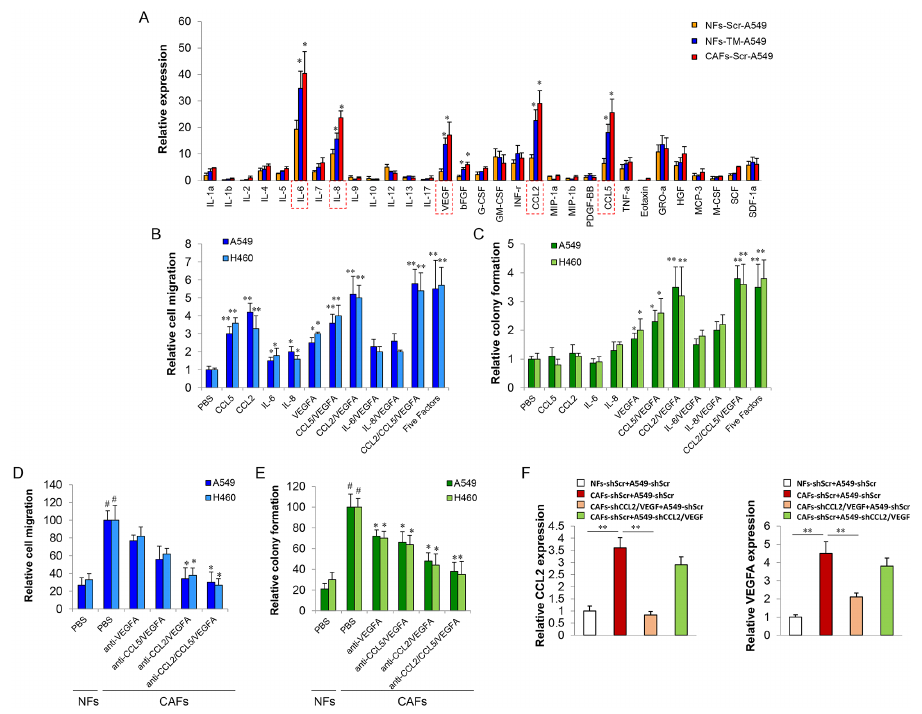
Fig 3. CCL2/VEGFA plays major roles in CAFs and LCCs co-cultured system. (A) A549 was co-cultured with NFs-Scr, NFs-TM, or CAFs-Scr for 48 h. The levels of various factors in the cell-free culture supernatants were measured by Bio-Plex cytokine array. All cytokines levels were normalized to the levels of IL-1 α in the CM of NFs-Scr-A549 co-culture. The relative levels of each cytokine were compared to the particular cytokine. Date is shown as fold induction of triplicates. (B,C) Cell migration assay and Colony formation assay was performed to determine LCCs cell migration and colony formation ability when treated with indicated secreted factor(s). * p < 0.05, ** p < 0.001. (D,E) Cell migration assay and Colony formation assay was performed to determine LCCs cell migration and colony formation ability when treated with